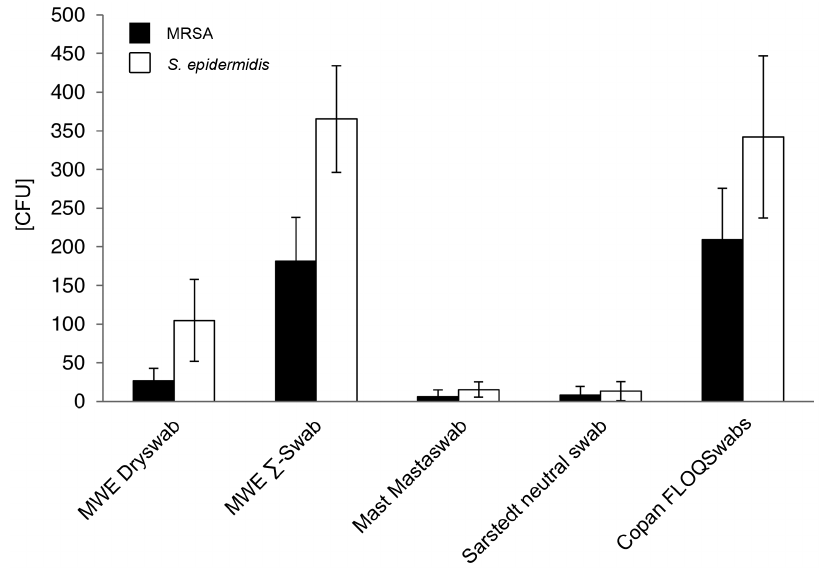
Figure 2. Recovery of bacteria in absolute numbers after elution into Amies medium. displayed swab-types into Amies medium were determined by CFU counting as described in the methods section. CFU=colony forming units. Results from statistical analysis are shown in Table S1.